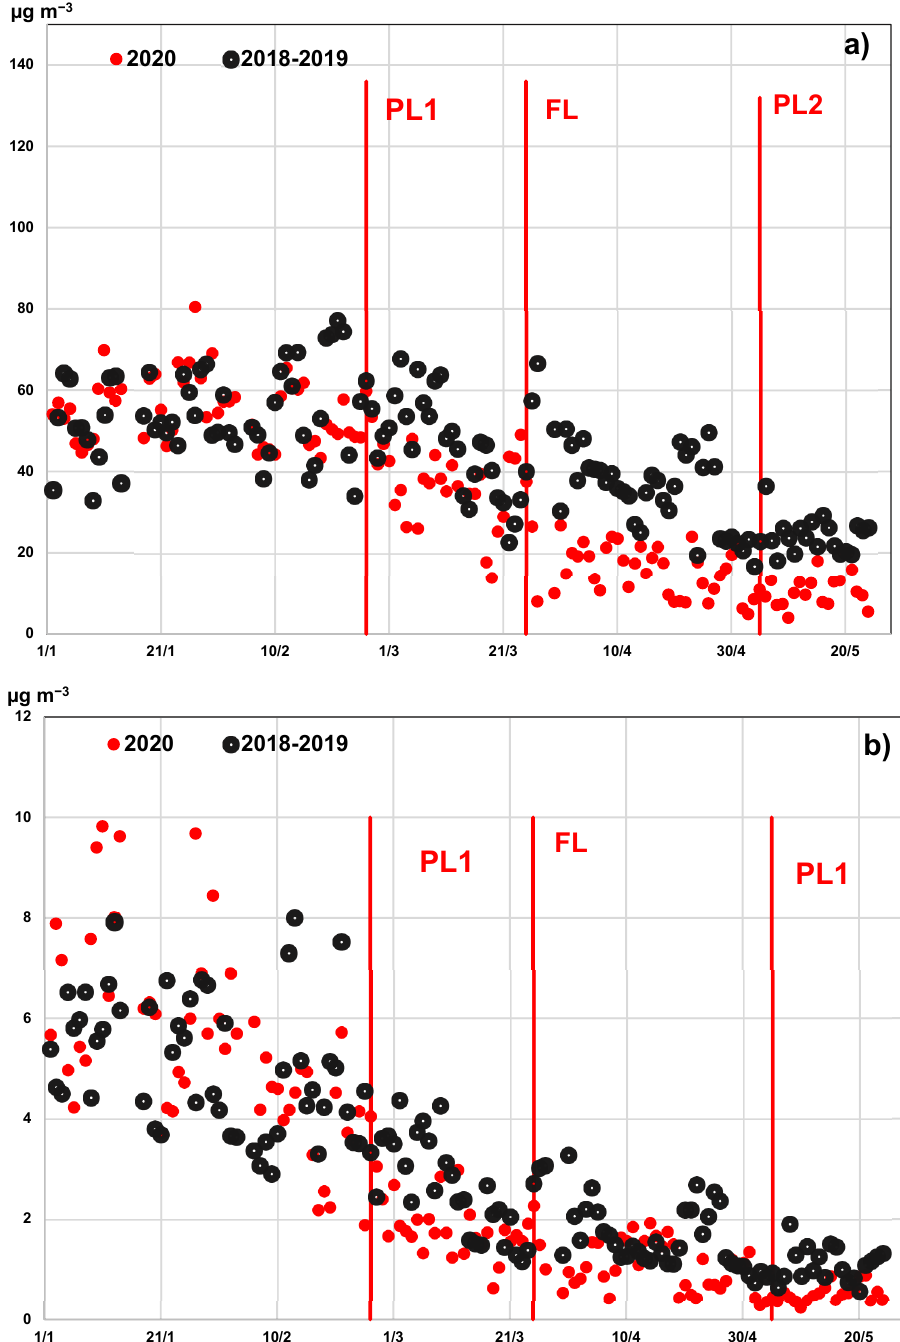
Figure 2. Temporal evolution of the concentration of air pollutants along the whole investigated time: comparison between the different lockdown periods in 2020 (red points) and 2018–2019 aggregated data representing a reference scenario (black empty circles). The vertical lines indicate the first day of each lockdown period, namely 26 February for PL1, 25 March for FL, and 5 May for PL2. ( a ): NO 2 concentration; ( b ): BC concentration. Table 3. Reference scenario of air quality in the investigated area: means and standard deviation values of 2018–2019 aggregated data computed in each time span corresponding to different lockdown periods. Impact of lockdown restrictions measured: % bias of air quality data in 2020 compared with 2018–2019 values in each equivalent period.